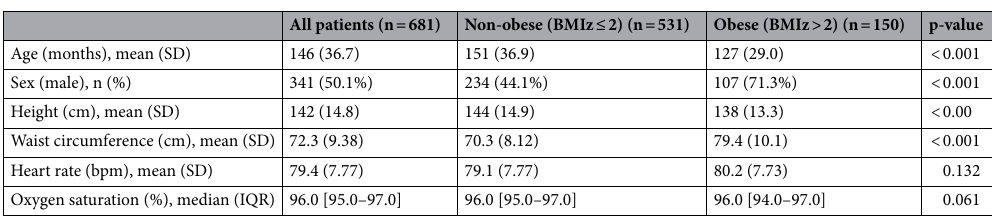
Table 1. Baseline characteristic. BMIz BMI Z-score, SD standard deviation, IQR interquartile range.